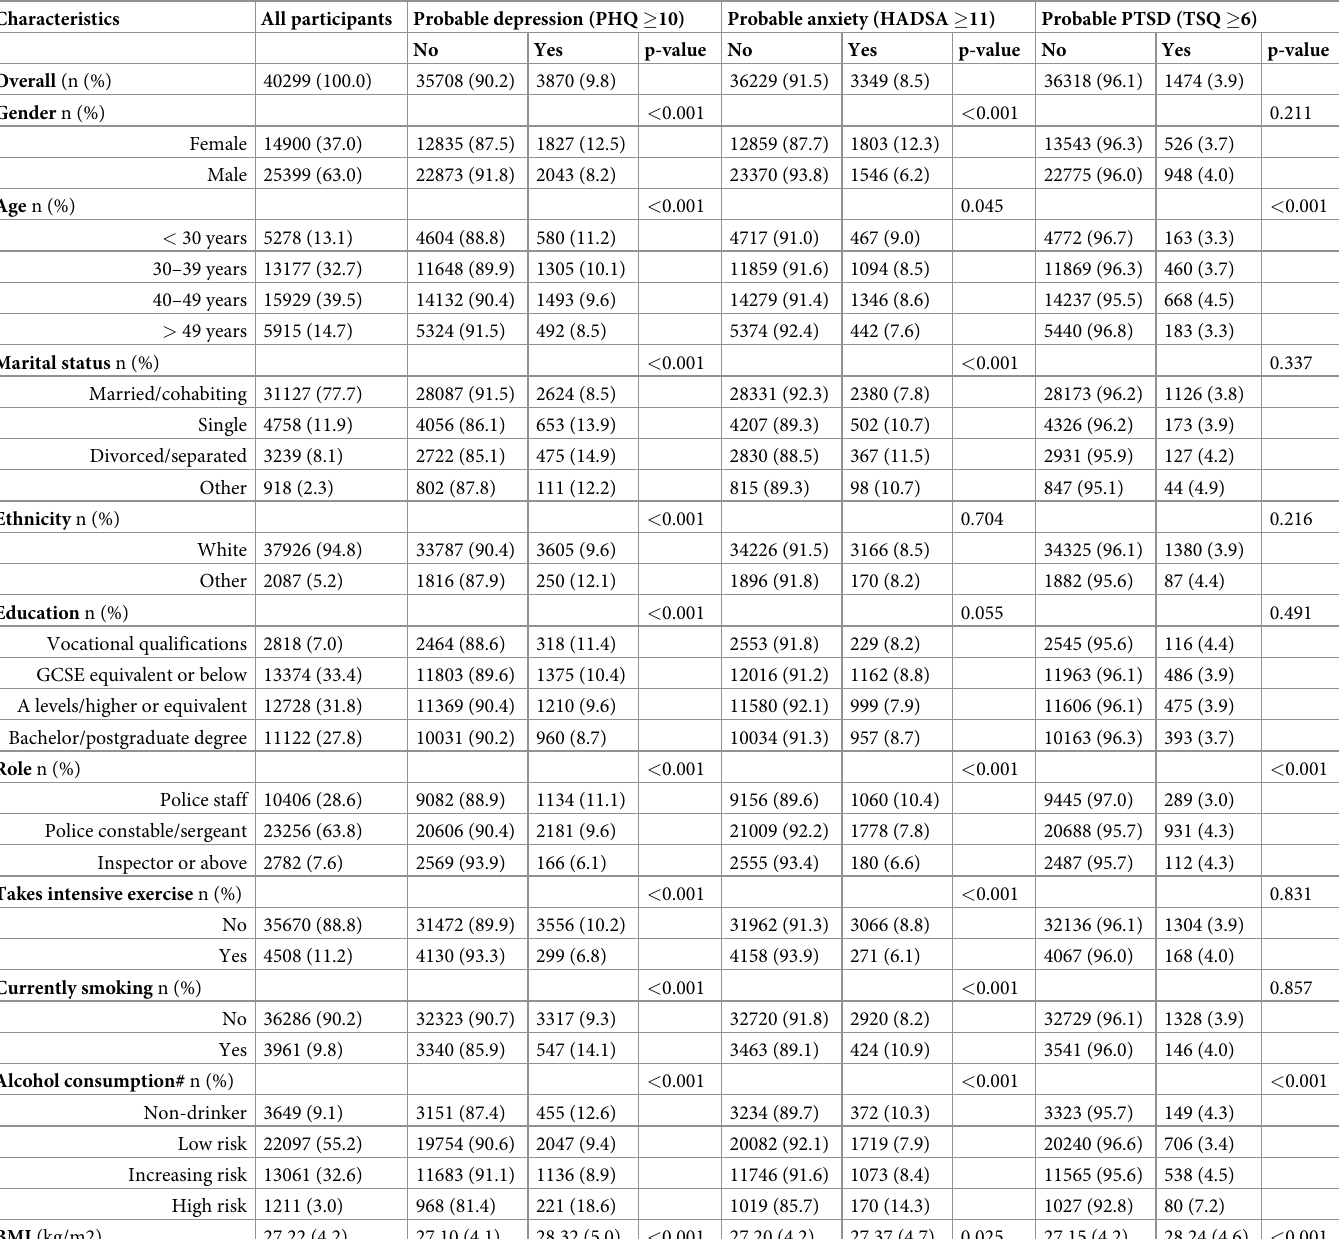
Table 1. Characteristics of police employees across probable mental disorders.